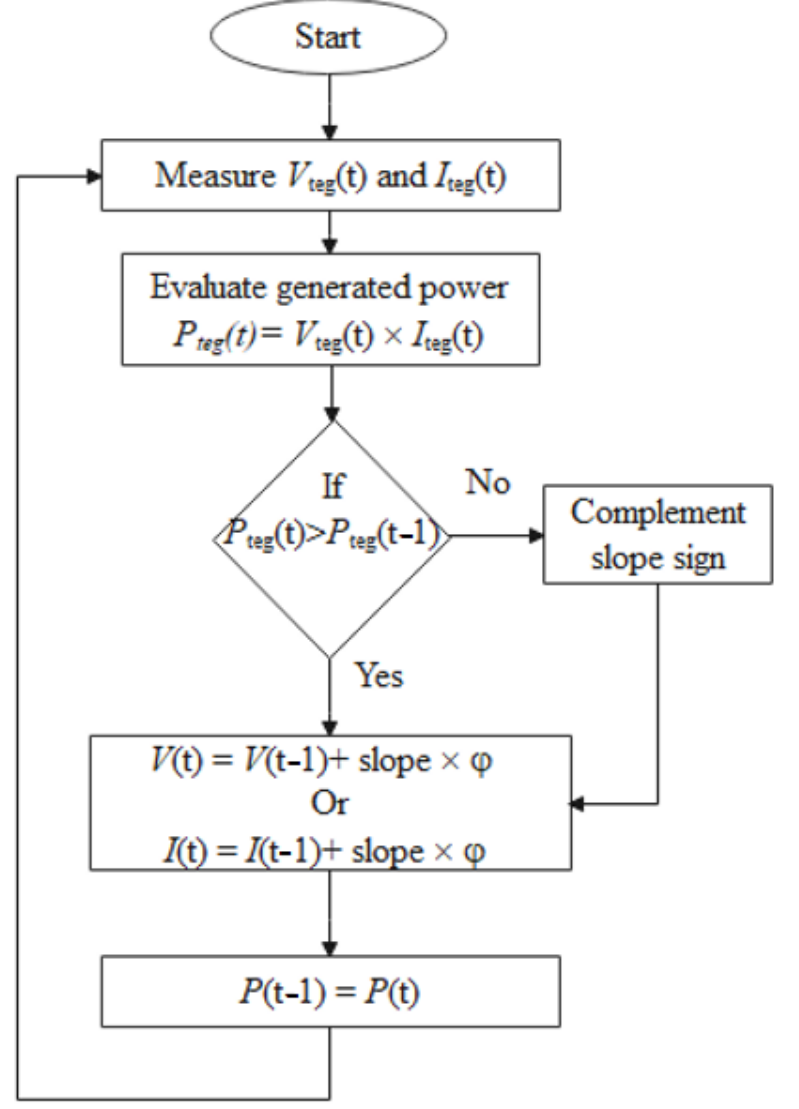
Figure 1. Flowchart of conventional P&O methodology.